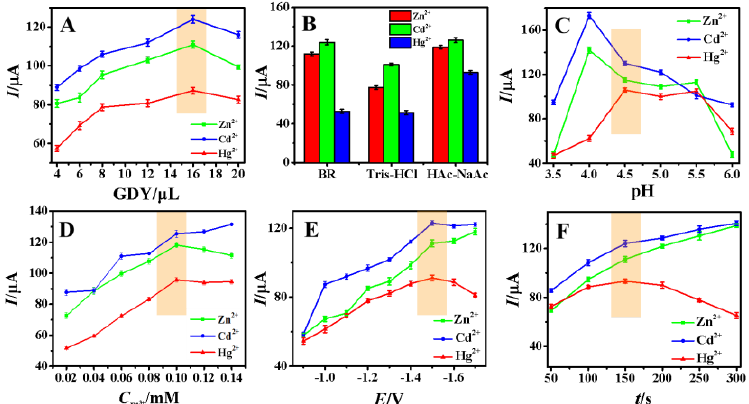
Figure 6. The effect of ( A ) different volumes of 1.0 mg/mL GDY suspension, ( B ) the types of 0.1 M supporting electrolytes (HAc–NaAc, Tris–HCl, BR), ( C ) pH of HAc–NaAc, ( D ) the concentration of Bi 3+ , ( E ) deposition potentials and ( F ) deposition time on the stripping currents of Zn 2+ , Cd 2+ , and Hg 2+ (n = 3). The orange area is the selected experimental